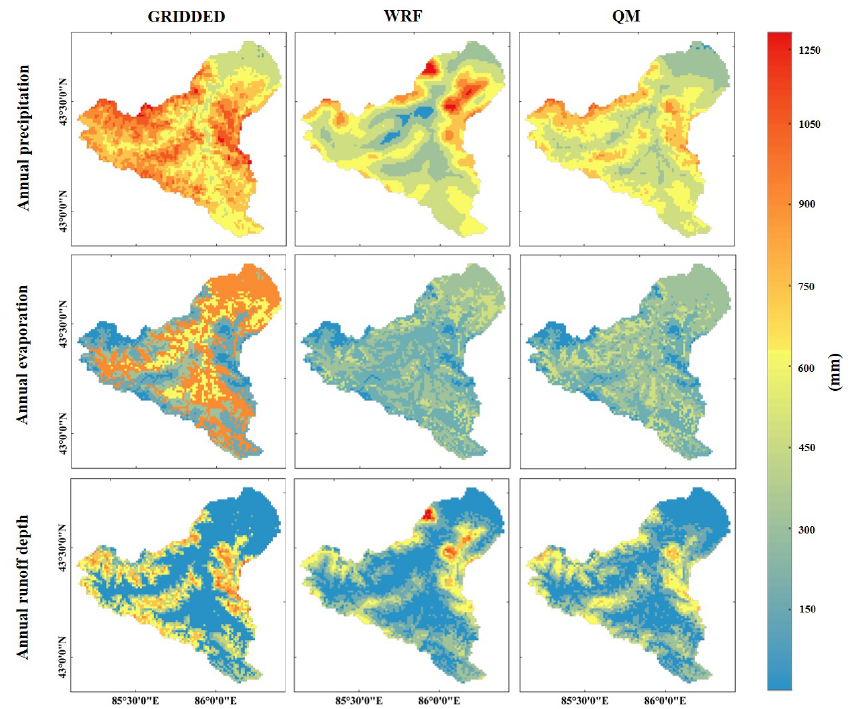
Figure 8. Spatial distribution of annual precipitation, evaporation, and runoff depth from the simulated results by the GRIDDED precipitation, the WRF downscaled precipitation, and the QM frequency corrected precipitation